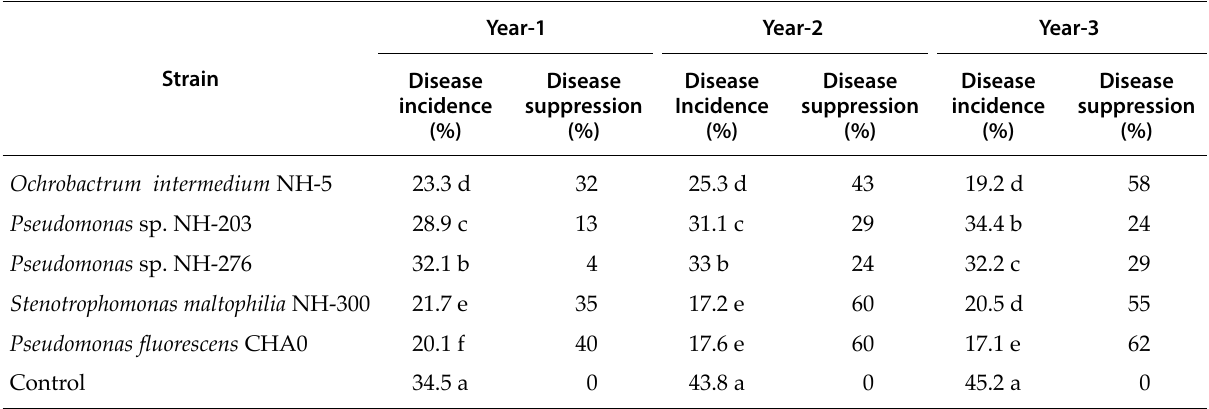
Table 7. Effect of the antagonistic bacteria on the incidence of red rot disease caused by Colletotrichum falcatum on sugarcane in “soil inoculation” experiments.